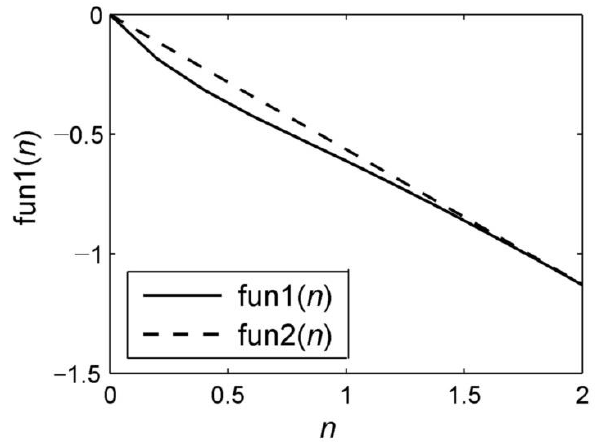
Figure 1. Comparison of curves for functions fun1( n ) and fun2( n ).